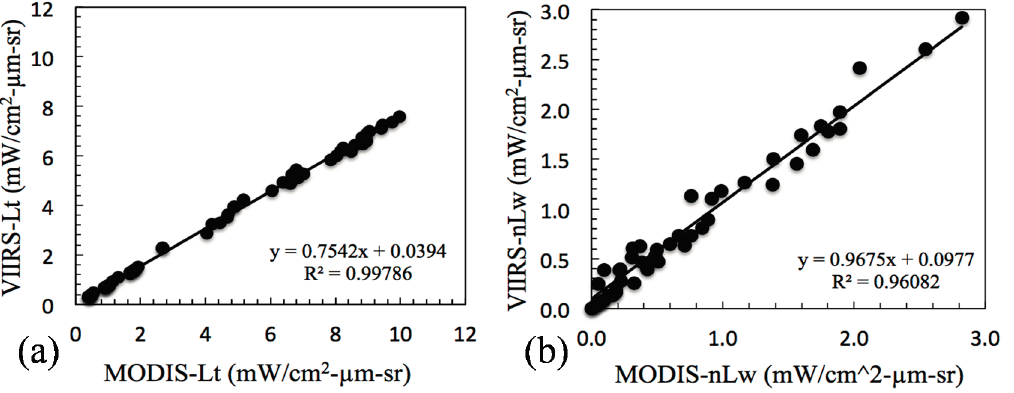
Figure 11. Data from MODIS and VIIRS imagery collected on 9 March 2013: ( a ) scatter plot of VIIRS versus MODIS Lt for the eight locations marked in Figure 9 with best-fit least-squares regression line, and ( b ) scatter plot of VIIRS versus MODIS nLw with best fit least-squares regression